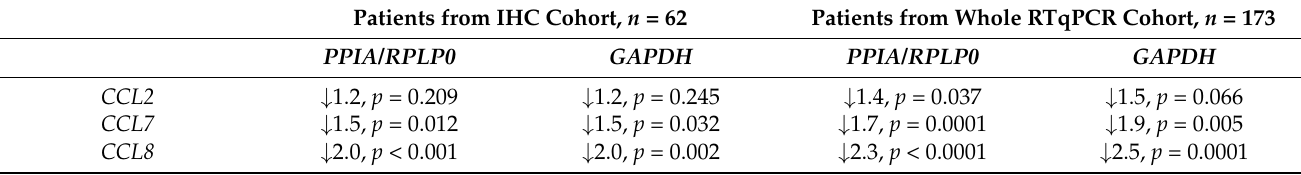
Table 3. CCL2 , CCL7 , and CCL8 expression in colorectal adenomas. Patients from IHC Cohort, n = 62 Patients from Whole RTqPCR Cohort, n = 173 PPIA/RPLP0